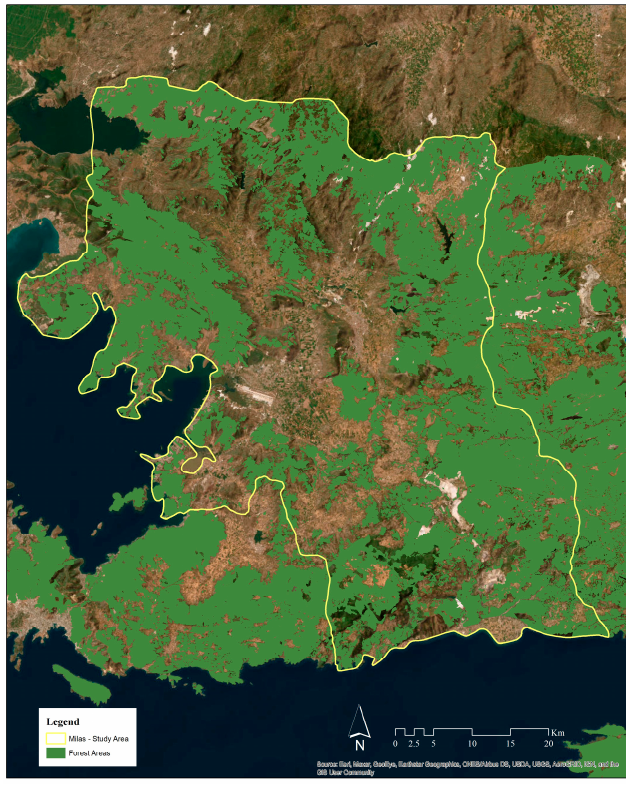
Figure 9. Forest areas.